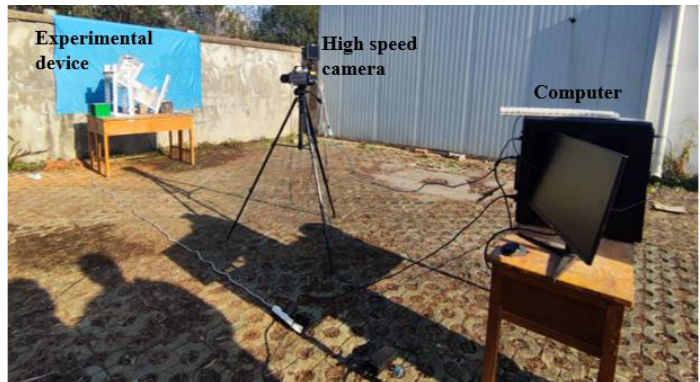
Figure 4. Test system. Figure 4. Test Table 2. Experimental conditions for underwater rock-plug blasting.